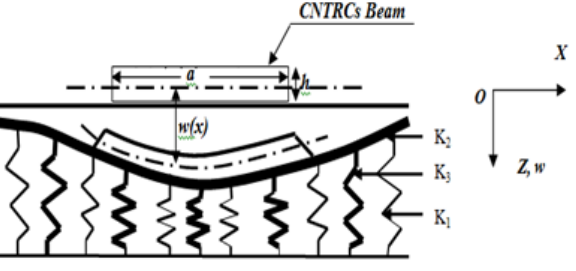
Figure 1: Geometry of CNTRC beam resting on nonlinear elastic foun- dation.